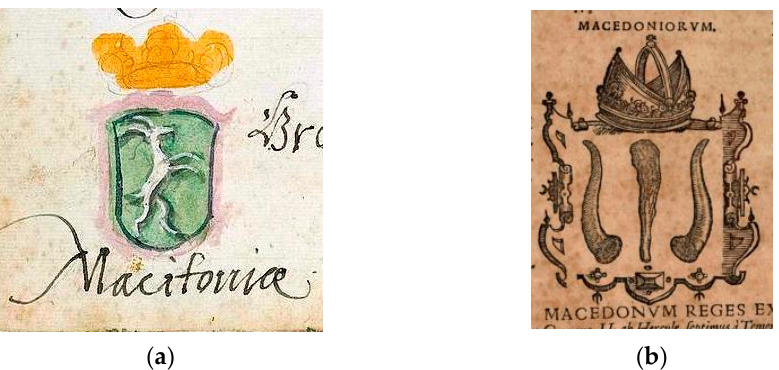
Figure 9. ( a ) Arms of Macedonia, Joachim Windhag ( b ) Arms of Macedonia, Hieronymus Henninges.